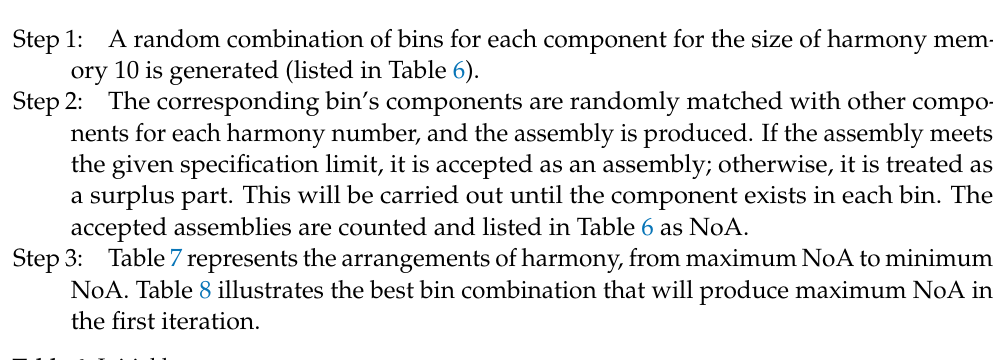
Table 6. Initial harmony memory.